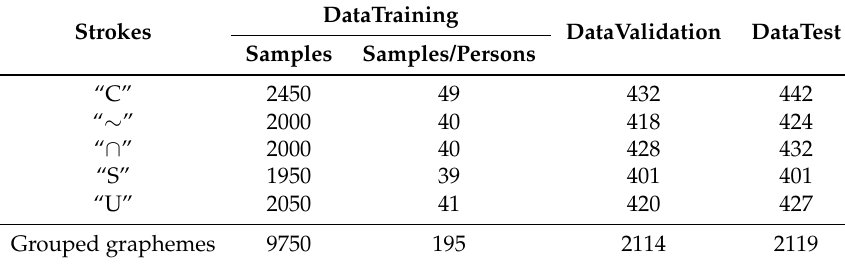
Table 3. Datasets